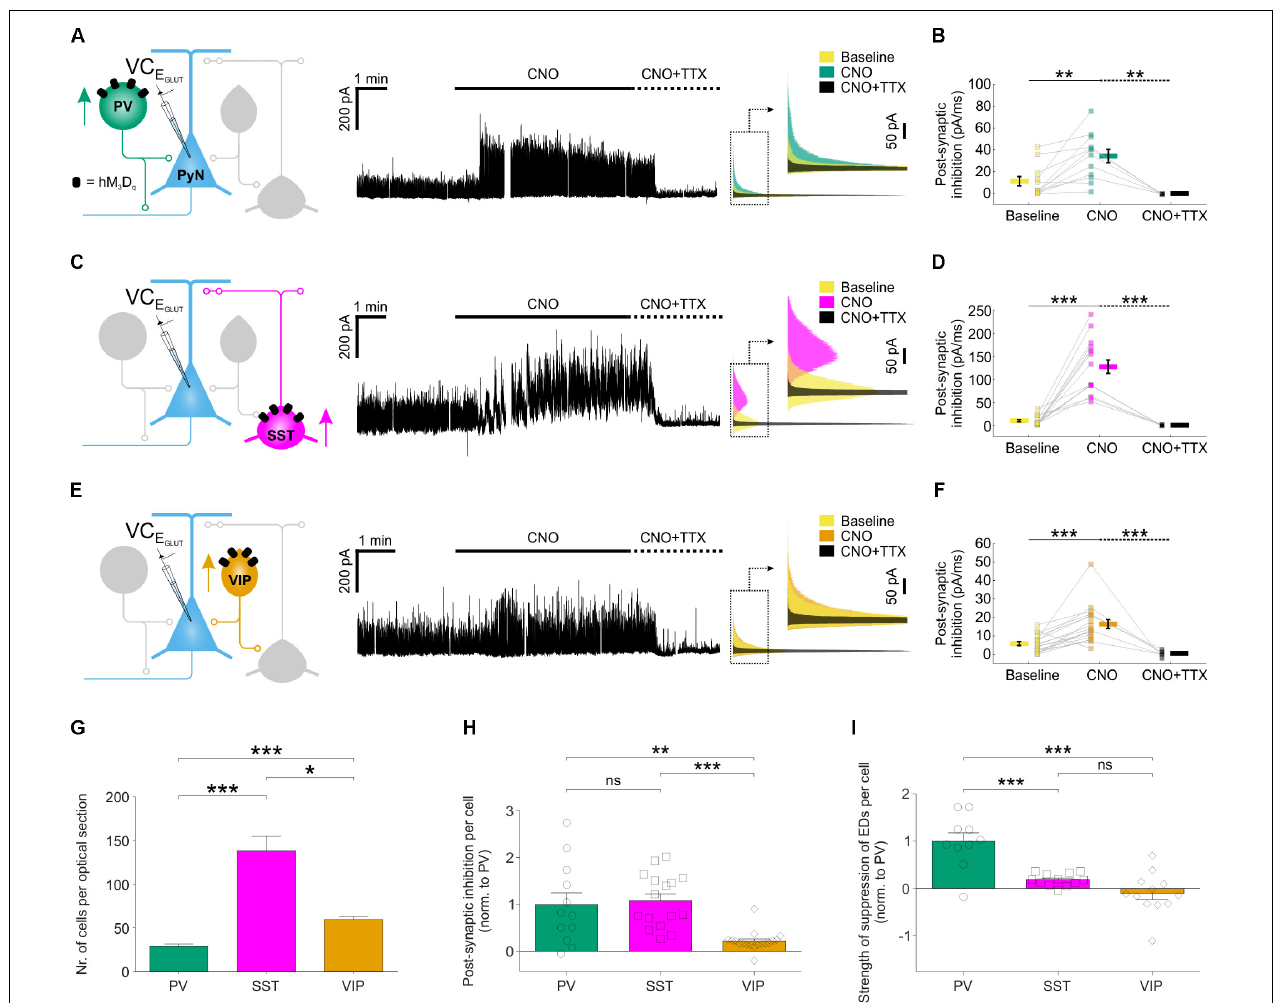
FIGURE 5 | Chemogenetic recruitment of interneuron populations generates different amounts of post-synaptic inhibition in pyramidal neurons. (A) hM 3 D q receptors were targeted to PV interneurons and voltage-clamp recordings (at E GLUT ) were performed from pyramidal neurons (left). CNO application elicited a pronounced increase in inhibitory post-synaptic currents converging upon the pyramidal neuron (middle). This increase was associated with spiking activity as it was abolished by bath application of TTX. Overlapping histograms (right) illustrate the probability distribution functions for the inhibitory post-synaptic currents during baseline, CNO, and co-administration of CNO plus TTX. (B) PV recruitment resulted in a significant change in total post-synaptic inhibitory charge converging onto pyramidal neurons [ F ( 2 , 26 ) = 9.541, p = 0.0008, one-way ANOVA, followed by post hoc Sidak’s multiple comparisons tests; baseline vs. CNO, N = 12, p = 0.0047; CNO vs. CNO plus TTX, N = 5, p = 0.0013]. (C) hM 3 D q receptors were targeted to SST interneurons and all conventions are the same as in (A) . (D) SST recruitment resulted in a significant change in total post-synaptic inhibitory charge converging onto pyramidal neurons [ χ 2 ( 2 ) = 29.77, p < 0.0001, Kruskal–Wallis test, followed